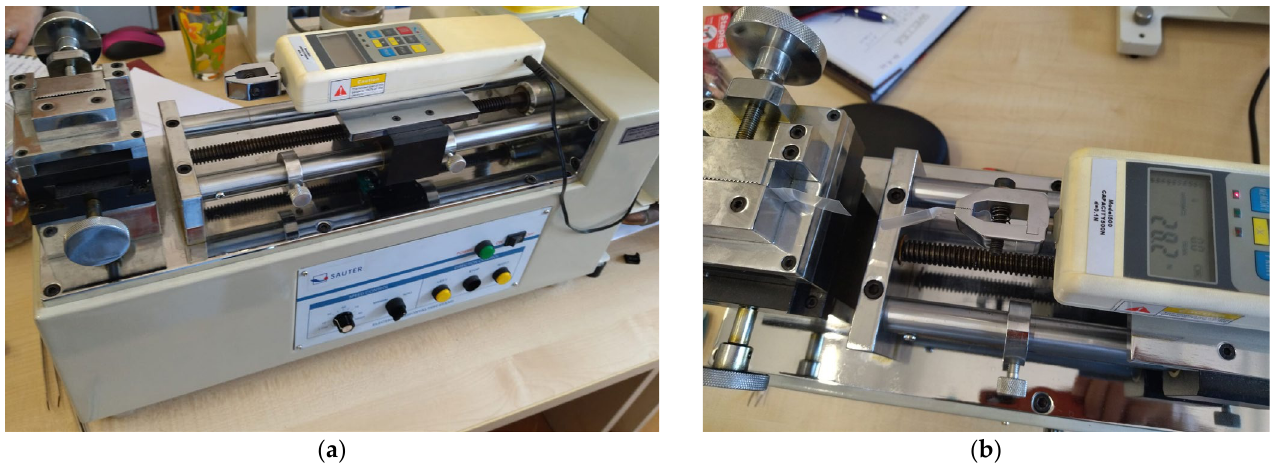
Figure 5. The measuring system for measuring breaking forces of an ultrasonic welded joint ( a ), test clamps with a test specimen after tearing ( b